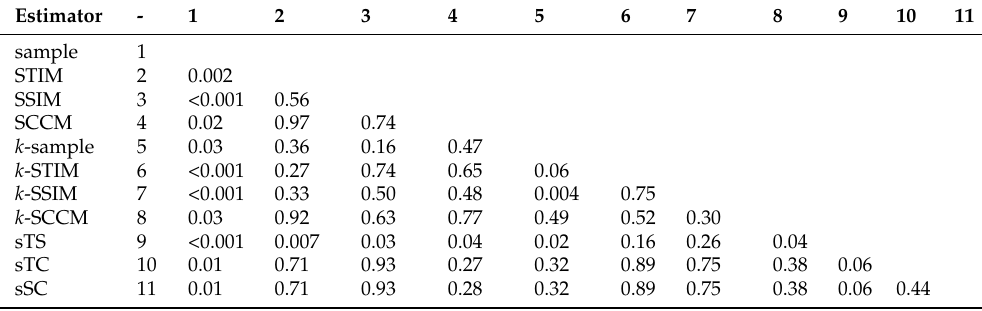
Table A2. p -Value of the Sharpe ratio for each pair of covariance estimators in Table 2.